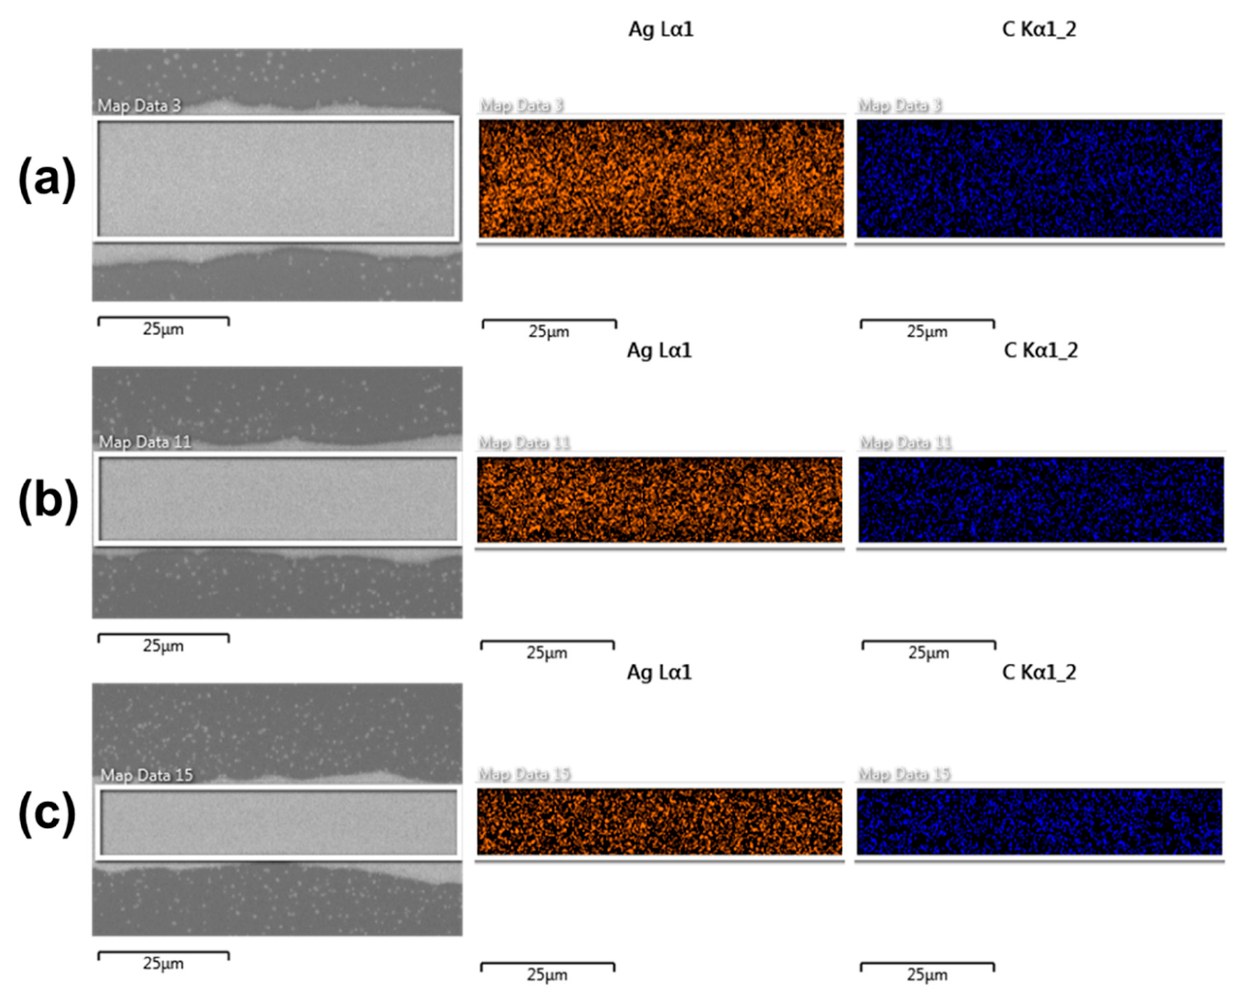
Figure 7. Scanning electron microscope (SEM) images and element distributions (Ag and C) scanned by energy-dispersive x-ray spectrometry (EDS): ( a ) 660 V; ( b ) 600 V; ( c ) 540 V. The mass percentages of Ag and C under different printing conditions were